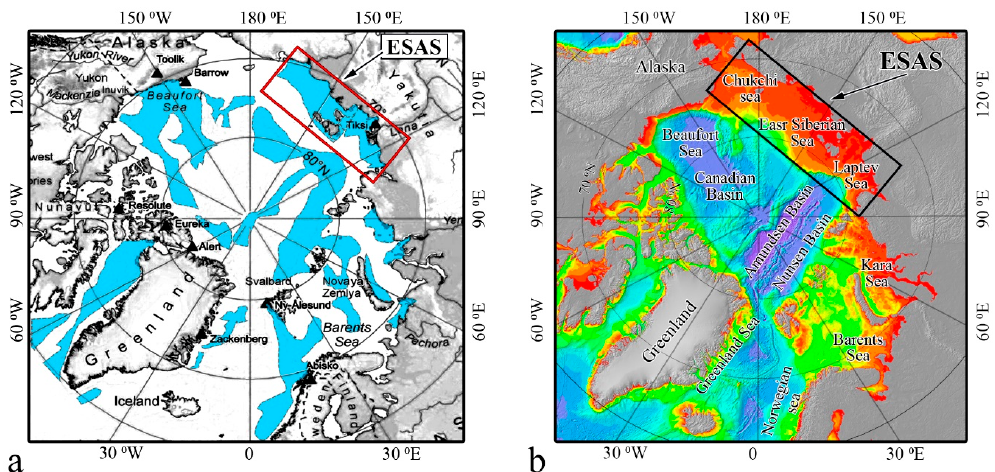
Figure 1. Maps of the Arctic Ocean (AO) highlighting specific features of the East Siberian Arctic Shelf (ESAS): ( a ) Predicted areas of hydrate deposits over the AO, including the shallow ESAS, shown in blue (after [14]); ( b ) bathymetry of the AO; red color refers to depth < 50 m [24]. As seen from the panels, the ESAS represents a major fraction of the AO shallow continental